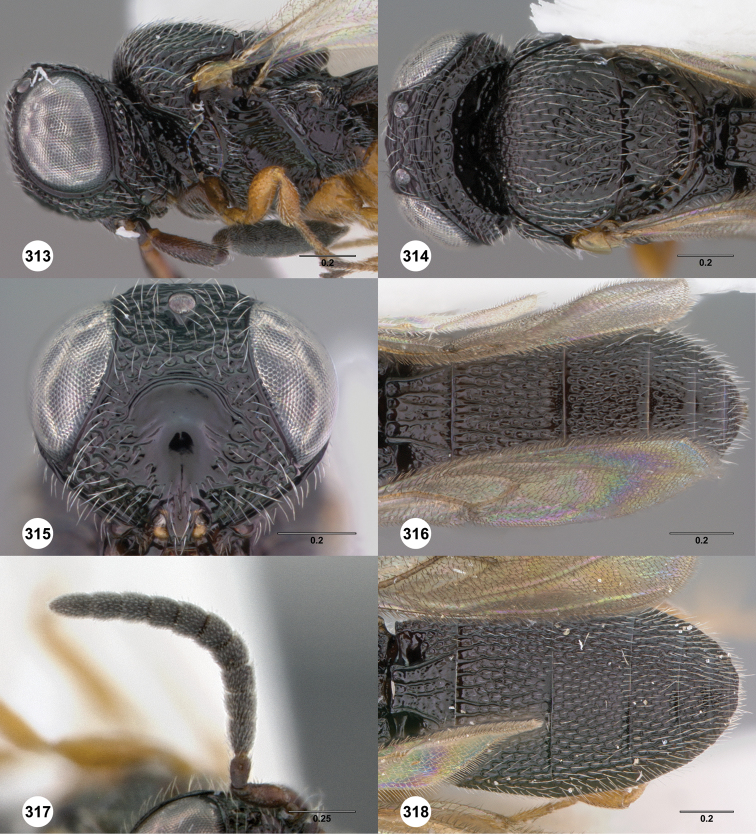
Oxyscelio scutorum sp. n., holotype female (OSUC 359721) 313 Head and mesosoma, lateral view 314 Head and mesosoma, dorsal view 315 Head, anterior view 316 Metasoma, dorsal view. Paratype male (OSUC 359730) 317 Antenna 318 Metasoma, dorsal view. Morphbank87